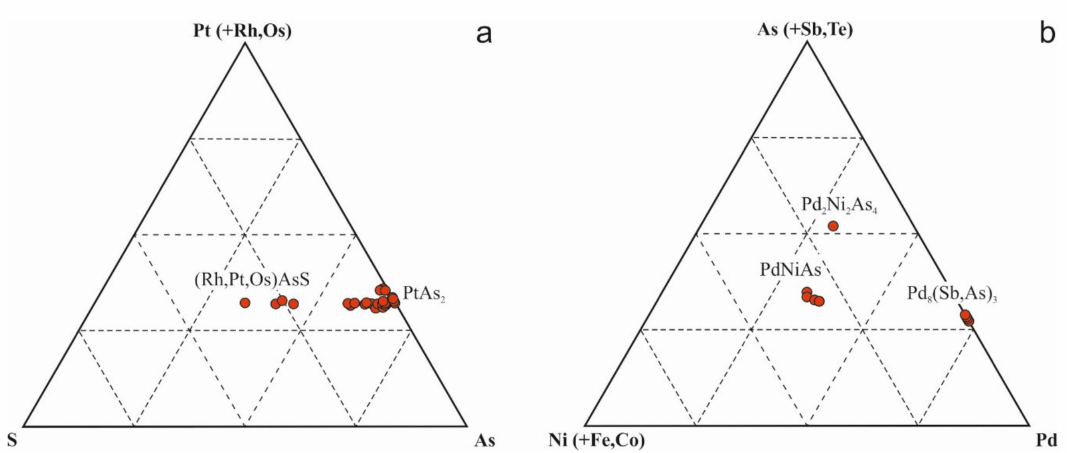
Figure 11. Composition of PGE minerals in the Nomgon massif: ( a ) solid solution of sperrylite PtAs 2 -hollingworthite (Rh,Pt,Os)AsS; ( b ) PGE mineral paragenesises for the Ni-As-Pd